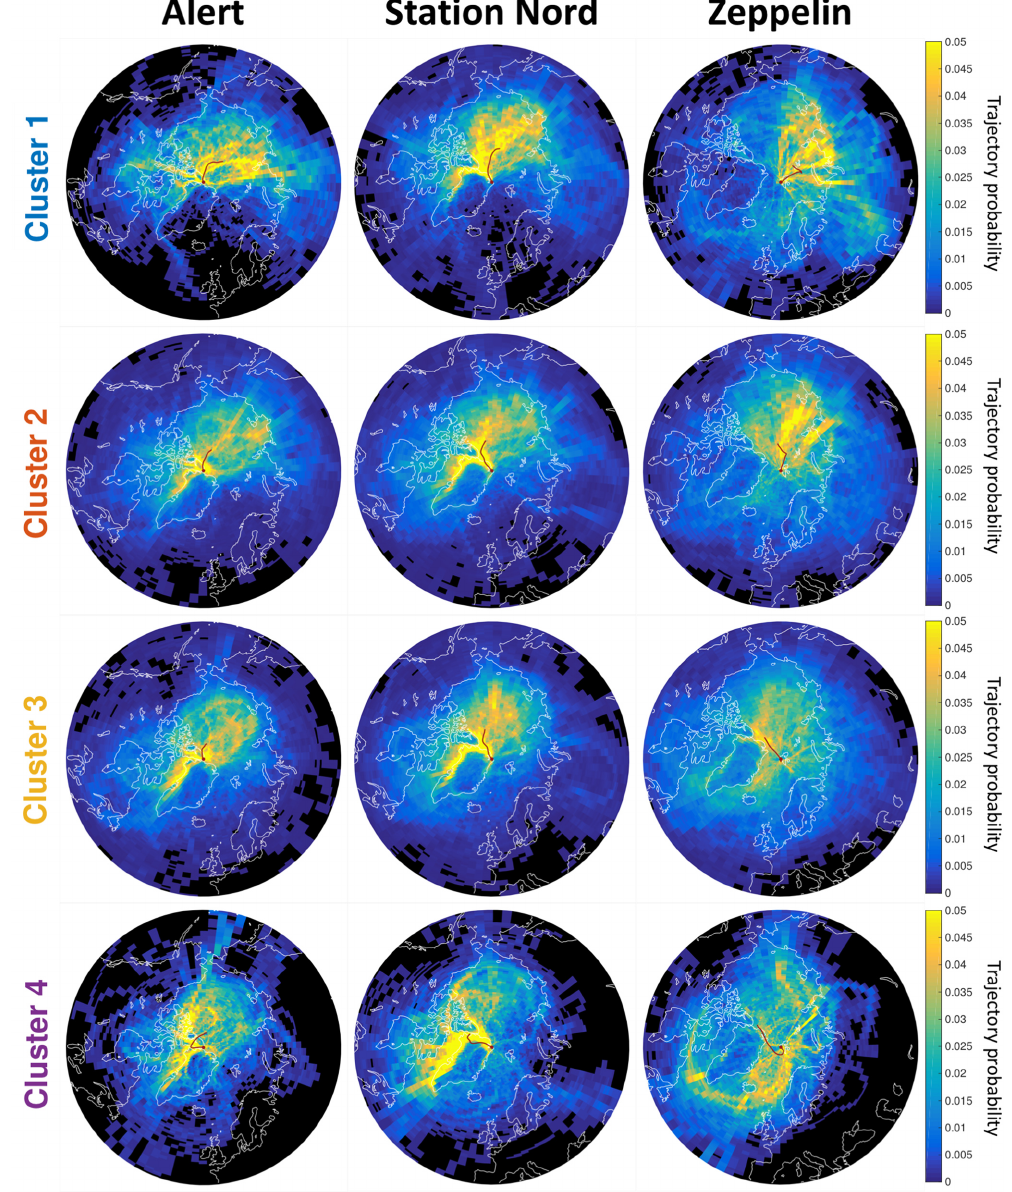
Figure 7. The trajectory density associated with each aerosol cluster and site. The values represent the probability of the 240h long trajecto- ries to cross the grid cells. Each cell is 0.5 and 4 ◦ wide in latitude and longitude, respectively, in a concentric coordinate system whose pole is at the measurement site. The yellow shading indicates trajectory probability greater than 5%. The geographical mean location of the 240h long back-trajectories is indicated in red. They are much shorter than the individual trajectories because trajectories at one side of the site cancel out the trajectories on the opposite side in spatial averaging. Still, the mean location gives an indication of the direction from which most trajectories arrive at the